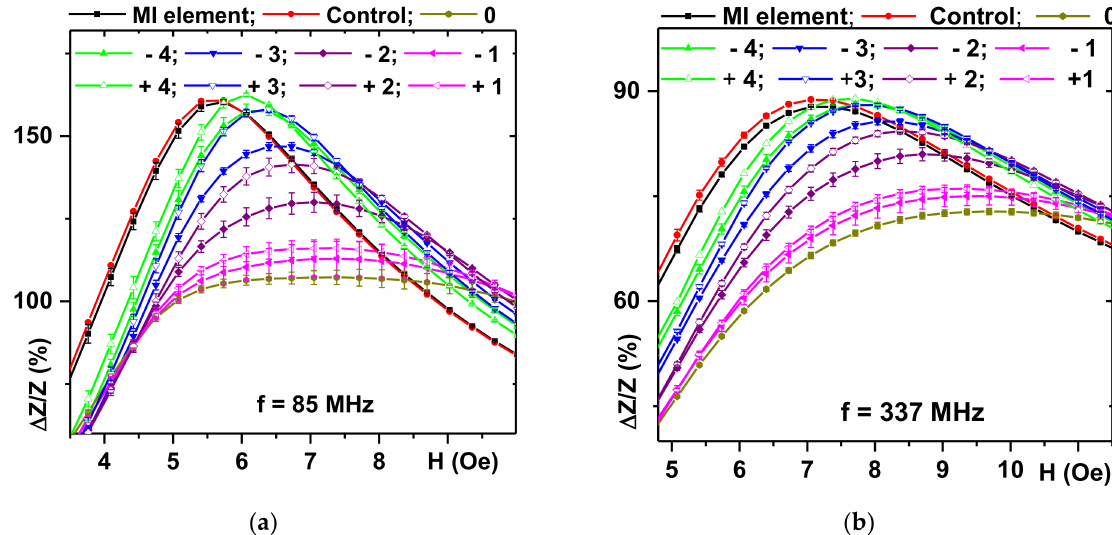
Figure 6. Field dependences of the MI ratio at the driving current frequencies of 85 ( a ) and 337 MHz ( b ) for different positions of epoxy composite samples (see also Figure 2a). MI responses of multilayered [FeNi (100 nm)/Cu (3 nm)] 5 /Cu (500 nm)/[Cu (3 nm)/[FeNi (100 nm)] 5 MI sensitive element itself and epoxy resin sample without magnetic particles are also given. Numbers indicate displacements in mm of the center of the cylindrical composite from zero position corresponding to the point just above the center of the MI element being elevated by 1.2 mm from the free side of the